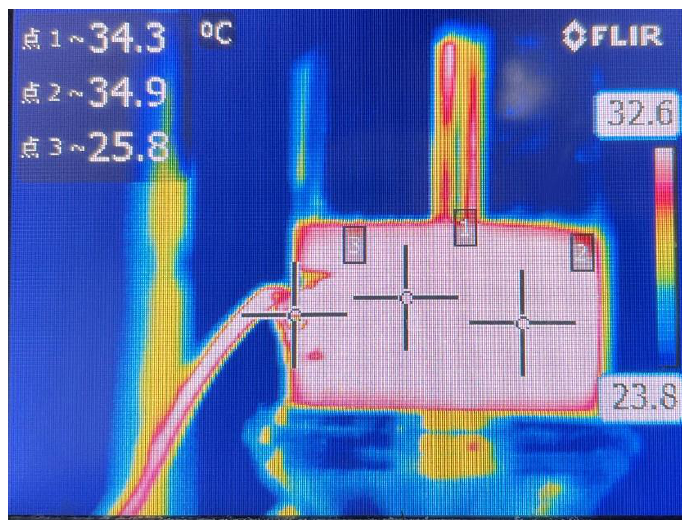
Figure 11. Temperature Distribution of the Transducer.